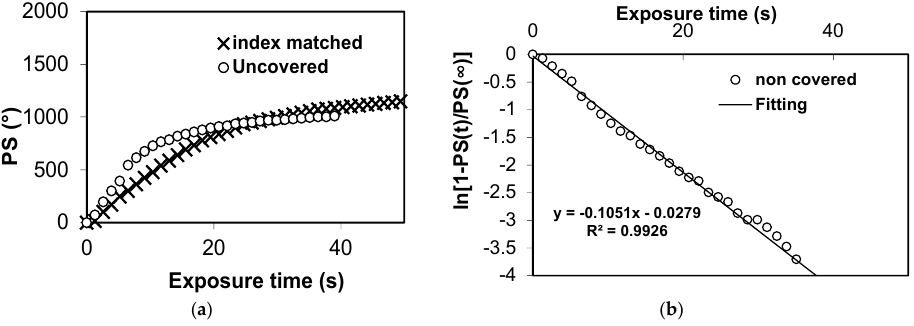
Figure 3. Phase shift (PS) at zero spatial frequency recording as a function of exposure time.